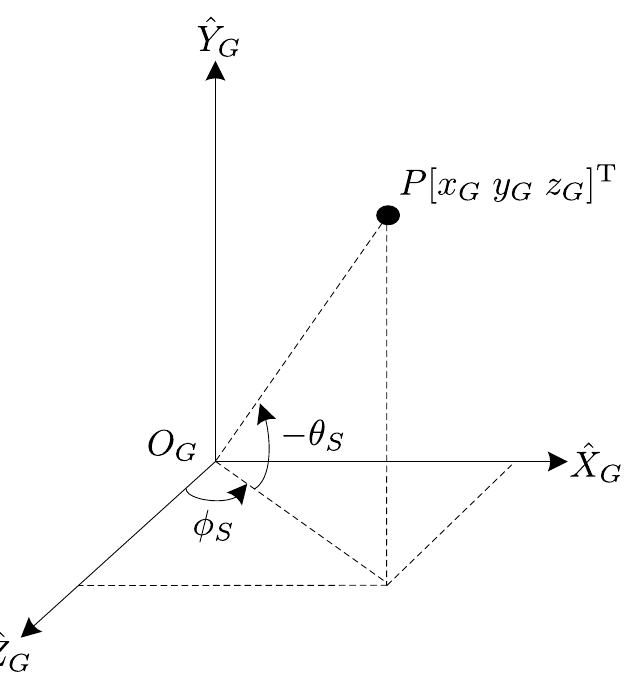
Figure 5. Angular motor